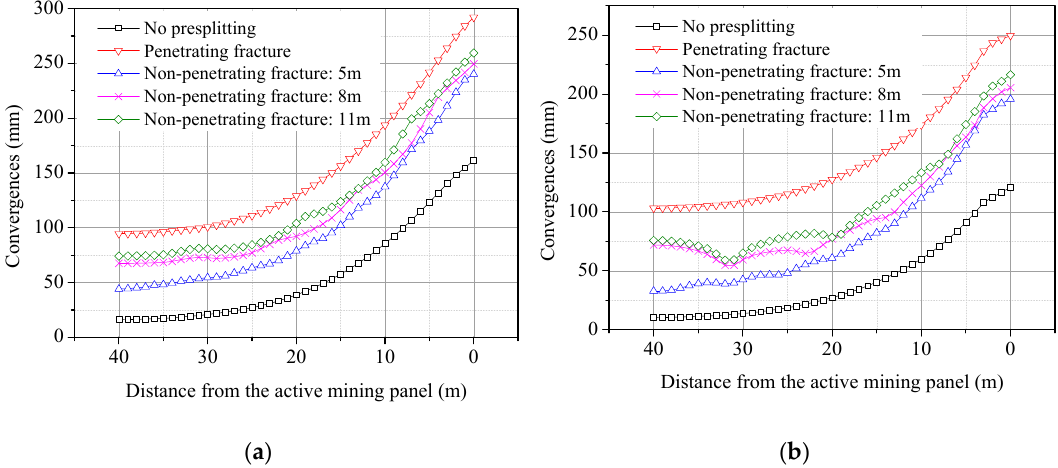
Figure 19. Deformation characteristics of the 6212 tail entry: ( a ) roof-to-floor convergence; ( b ) rib-to- rib convergence.